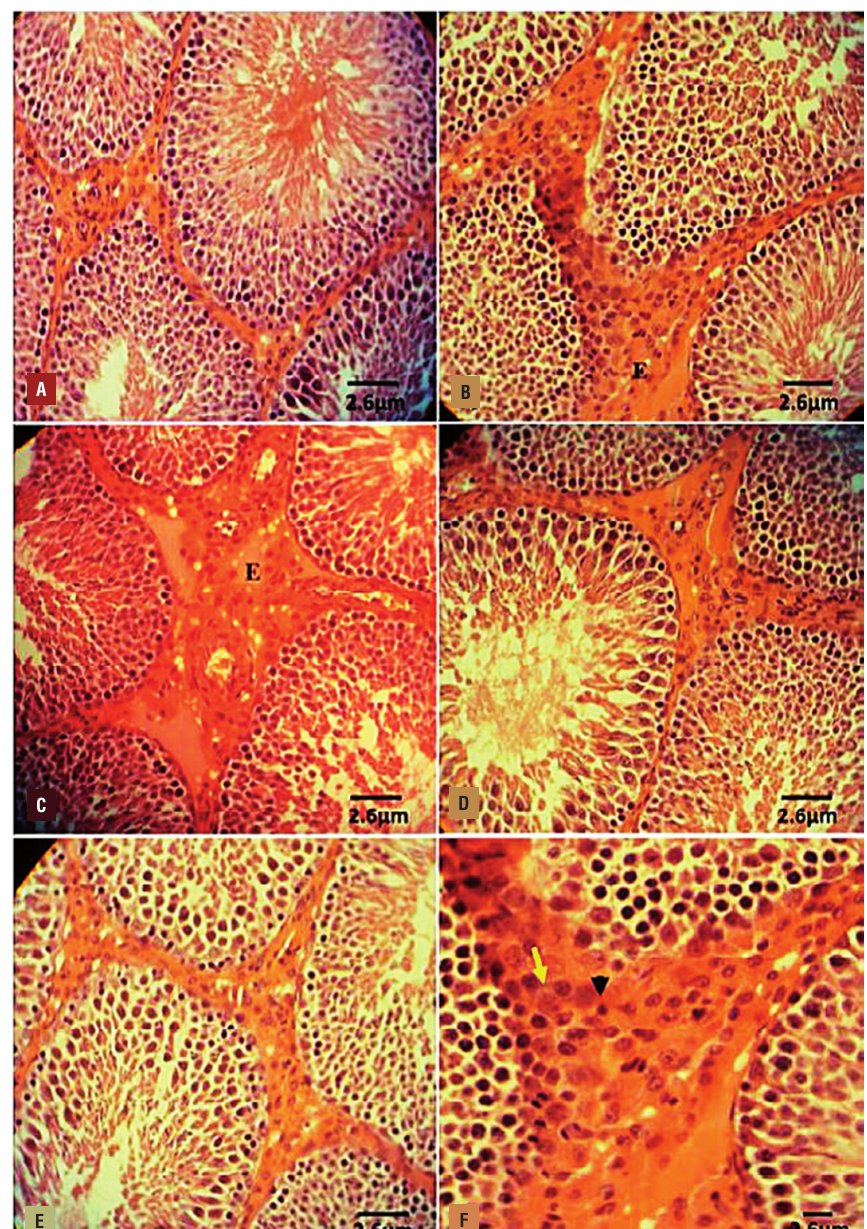
Figure 2 - Photomicrograph of rat testes. (A) Control-sham group: normal germinal epithelium with no edematous connective tissue; (B) VCL-induced group: testicular tissue represented with severe edema (E) in connective tissue and remarkable immune cells infiltration in interstitial tissue; (C) VitE-administrated group: the protected seminiferous tubules with positive TDI and RI are observed, while the edematous interstitial tissue (E) is remained unchanged; (D) DEX received group: note decreased edema and down regulated immune cells infiltration. The seminiferous tubules are presented with normal TDI and RI; (E) VitE+DEX-administrated group: the edema and immune cells infiltration significantly reduced versus figures D and E, and the tubules are presented close to normal; and (F) Higher magnification from interstitial tissue of non-treated VCL- induced testis: note mononuclear immune cell (head arrow) infiltration in edematous tissue and hypertrophied leydig cells (arrow) distribution. Iron-Weigert staining technique